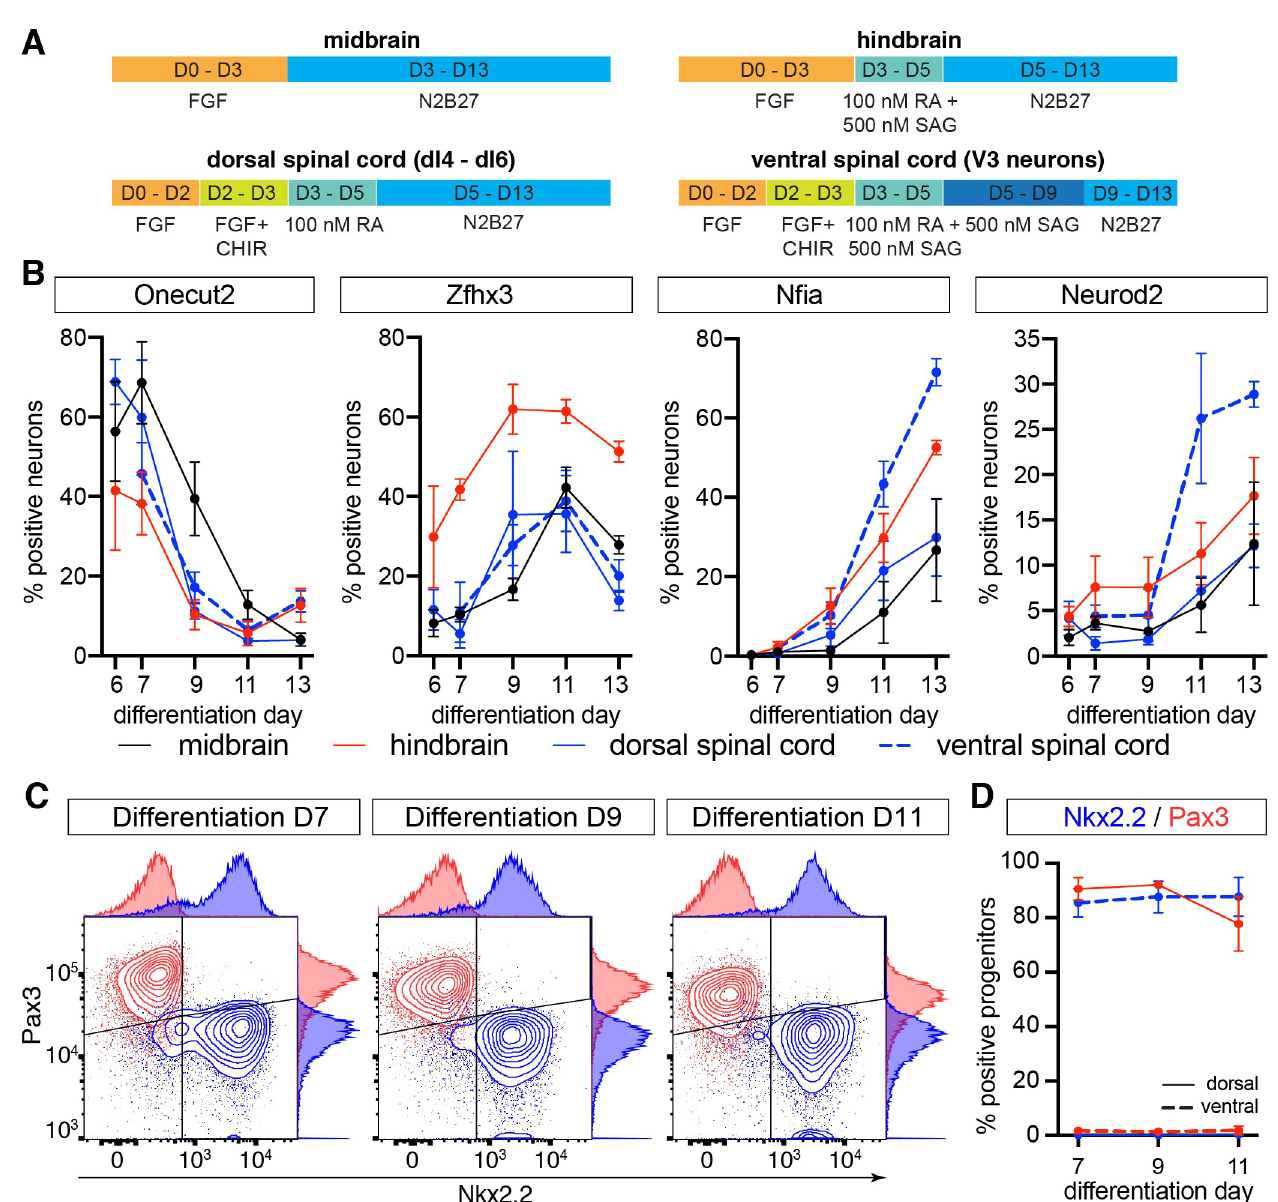
Fig 4. Conservation of the temporal TF code in stem cell–derived neurons with different axial and dorsal–ventral identities (see also S11 Fig). (A) Schematics of the differentiation protocols for the generation of progenitors and neurons with different axial and dorsal–ventral identities. (B) Flow cytometry analysis of temporal TF expression indicates that neurons with different axial and dorsal–ventral identities display the same temporal progression in vitro as in vivo. (C) Flow cytometry analysis of Nkx2.2 and Pax3 expression in neural progenitors in dorsal and ventral spinal cord differentiations. (D) Percentage of neural progenitors expressing Pax3 and Nkx2.2 in ventral and dorsal spinal cord differentiations between days 7–11. Underlying data are provided in S3 Data. FGF, fibroblast growth factor; RA, retinoic acid; SAG, Shh pathway agonist; TF, transcription